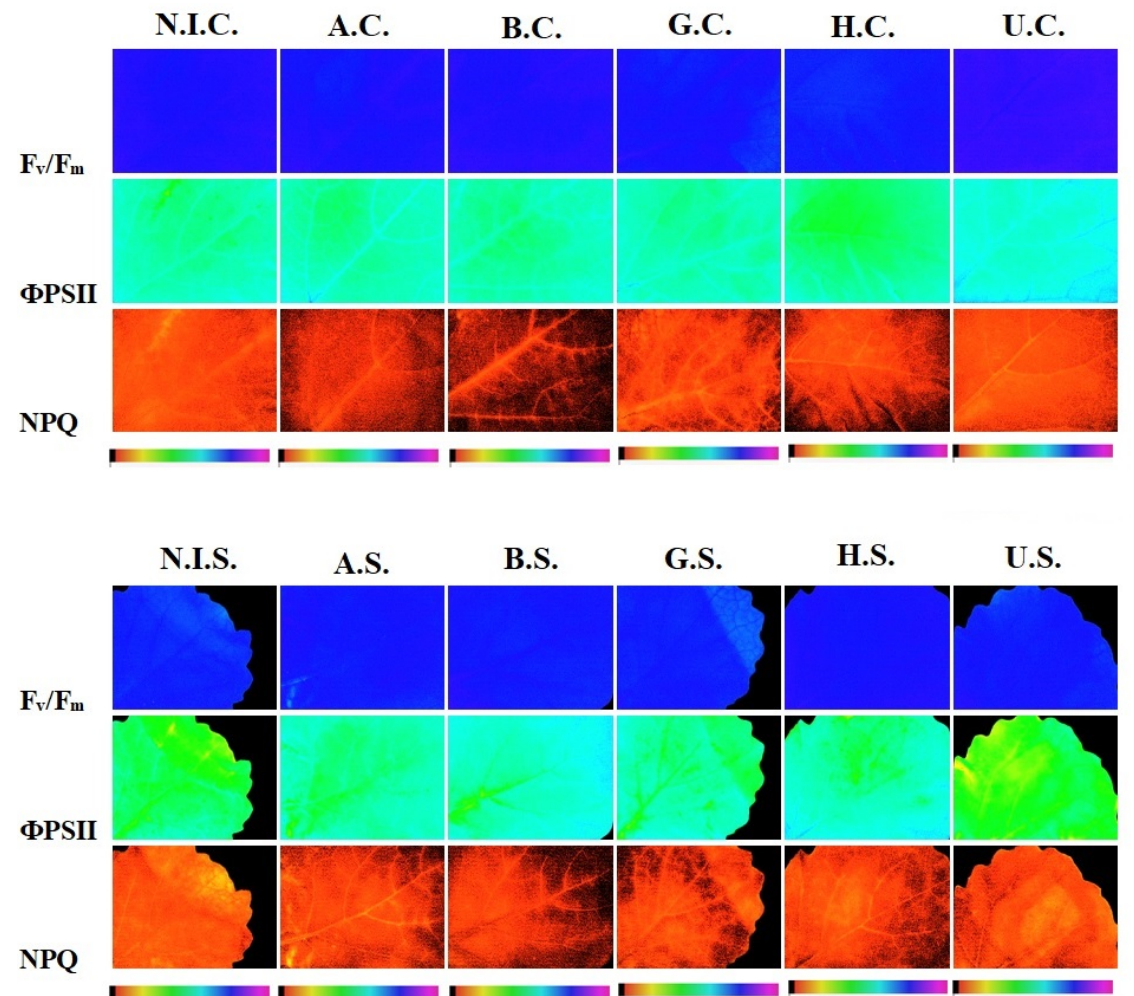
Figure 6. Chlorophyll fluorescence images of photochemistry (F v /F m ) in a dark-adapted leaf and PSII photochemistry ( Φ PSII) and non-photochemical quenching (NPQ) at steady-state with actinic illumination of 55 µ mol photons m − 2 s − 1 measured at the end of the experiment (30th day) in B. napus cv. SY Saveo plants grown in non-saline (C) and in saline soils (S). The false color code depicted at the bottom of the images ranges from 0.00 (black) to 1.00. N.I. = non- inoculated; A: A. brasilense ; B: B. ambifaria ; G: A. globiformis ; H: H. seropedicae ; U: Pseudomonas sp. Table 4. Chlorophyll fluorescence parameters, maximal quantum efficiency (F v /F m ) measured in dark-adapted leaves and quantum efficiency of PSII photochemistry ( Φ PSII), non-photochemical quenching (NPQ), and electron transport rate (ETR) measured at steady state with actinic light illumination of 55 μ mol photons m − 2 s − 1 in B. napus cv. SY Saveo plants grown for 30 days on non-saline soil (C) or saline soil (S). Plants were inoculated with plant growth-promoting bacteria (A = A. brasilense , B = B. ambifaria , G = A. globiformis , H = H. seropedicae , U = Pseudomonas sp. UW4) or not (N.I. = non inoculated). Different letters mean significant differences within the same bacterial treatment. Significant differences between inoculated or non-inoculated plants grown at the same soil conditions are marked as * ( p < 0.05) ( n = 4). F v /F m (r.u.) Φ PSII (r.u.)